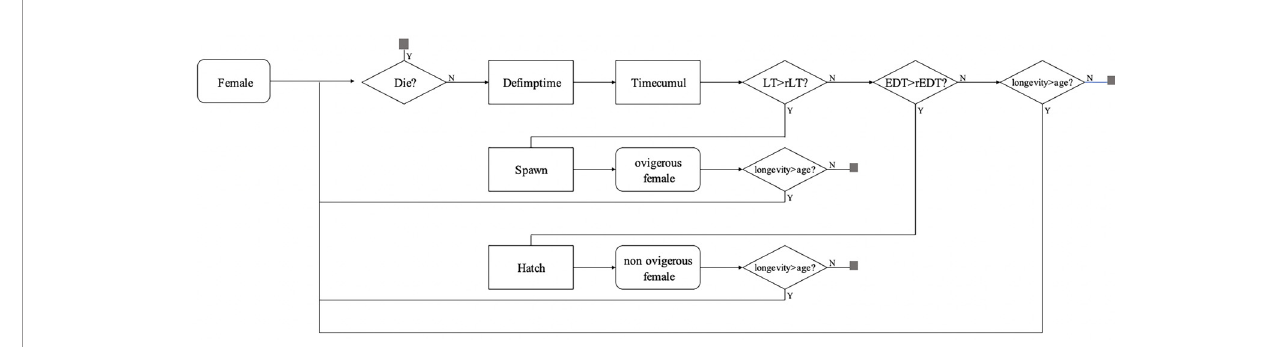
FIGURE 2 | Flow chart representing the scheduling of the model processes used to de fi ne the reproductive cycle of the copepod Apocyclops royi . The conditional tasks “ Spawn ” and “ Hatch ” respectively require the latency time (LT) and Embryonic Development Time (EDT) to reach a threshold value (rLT and rEDT) for their execution. The details on each task are presented in Table